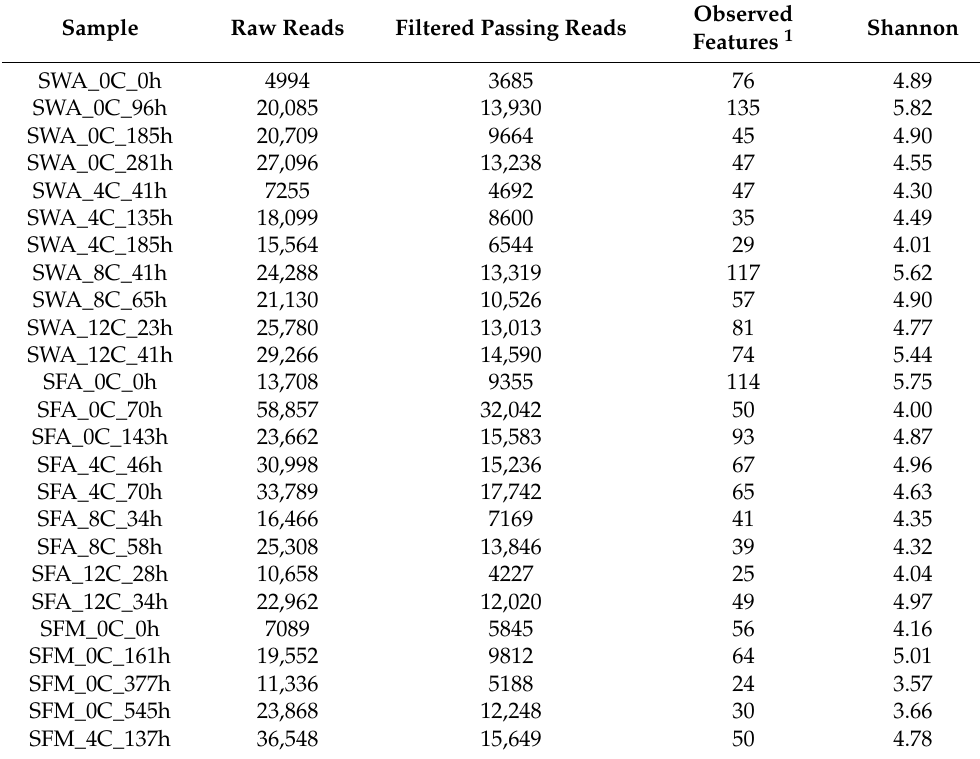
Table 3. Number of reads and alpha diversity indices of whole (SW) and filleted sea bass (SF) during storage (h) at various temperatures (C) under air (A) and MAP (M)